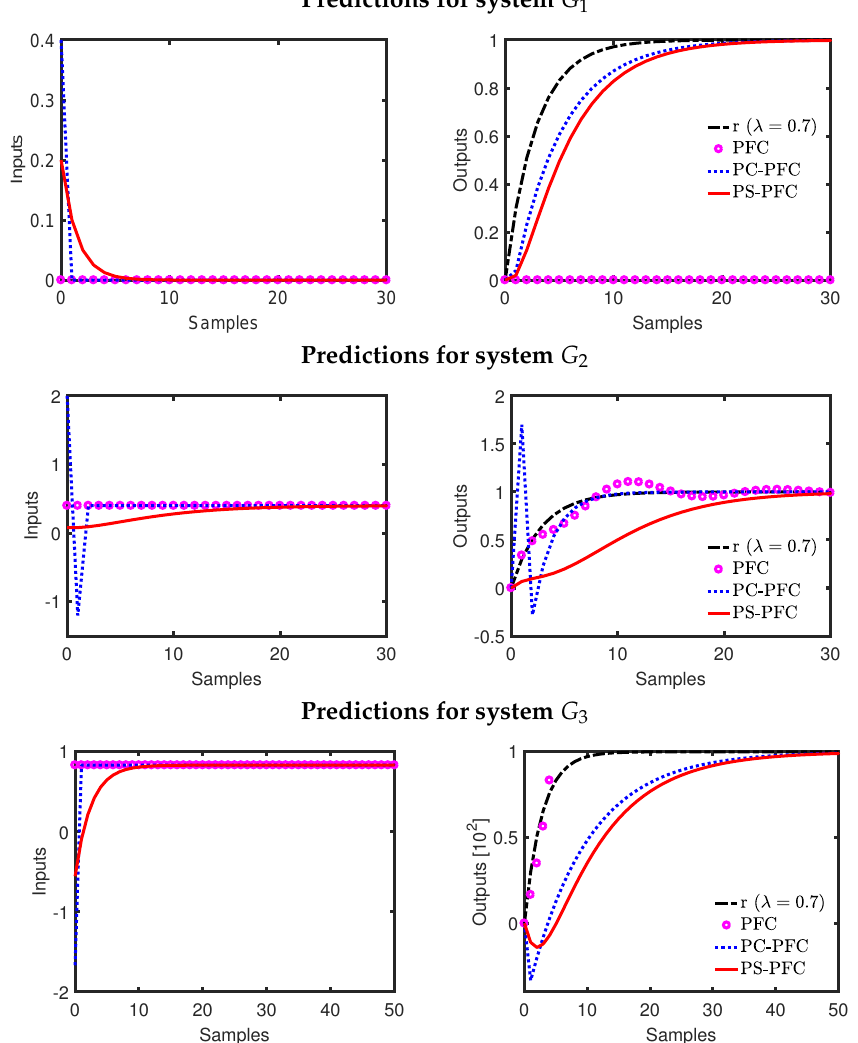
Figure 2. Input and output predictions with PFC, PC-PFC, and PS-PFC for processes G 1 , G 2 , G 3